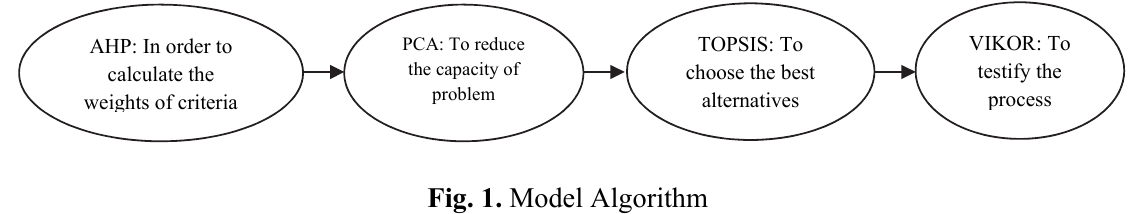
Fig. 1. Model Algorithm